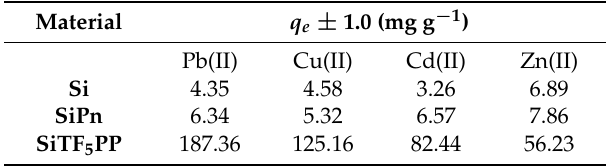
Table 2. Metal ion adsorption of Si , SiPn and SiTF 5 PP as contact time (30 min) function.